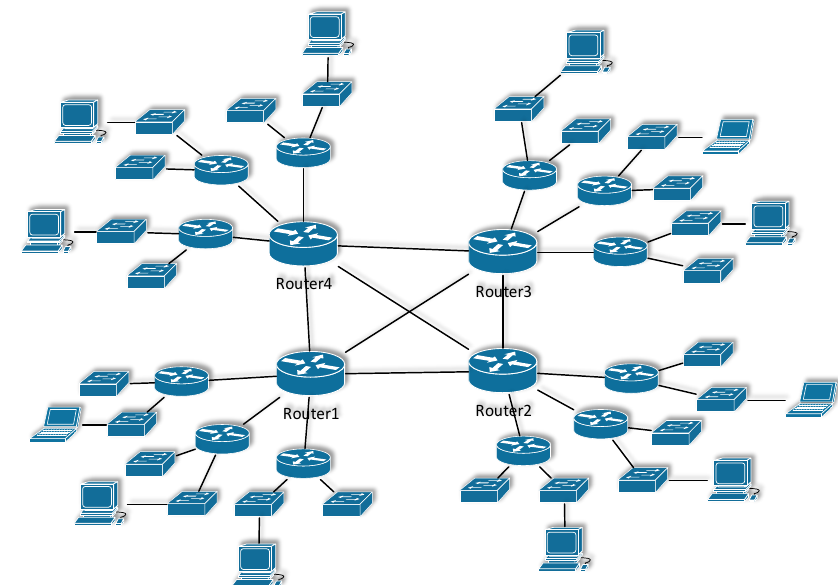
Figure 5. Topology of the investigated network.